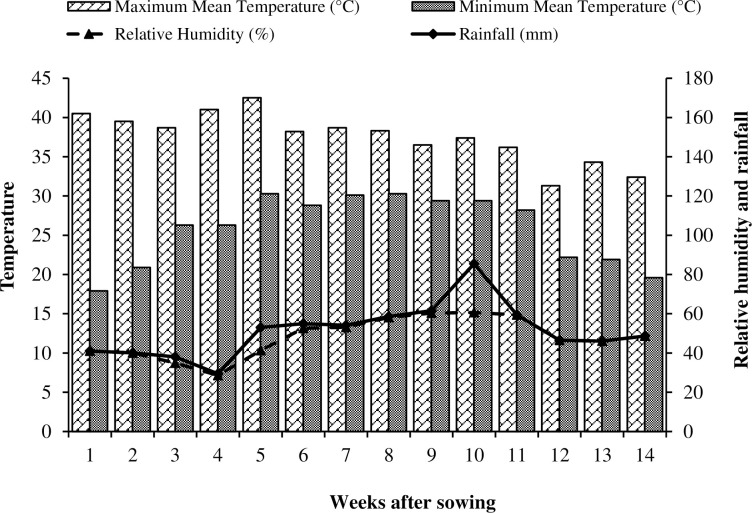
Meteorological data recorded at Bahauddin Zakariya University, Multan during experimental period.